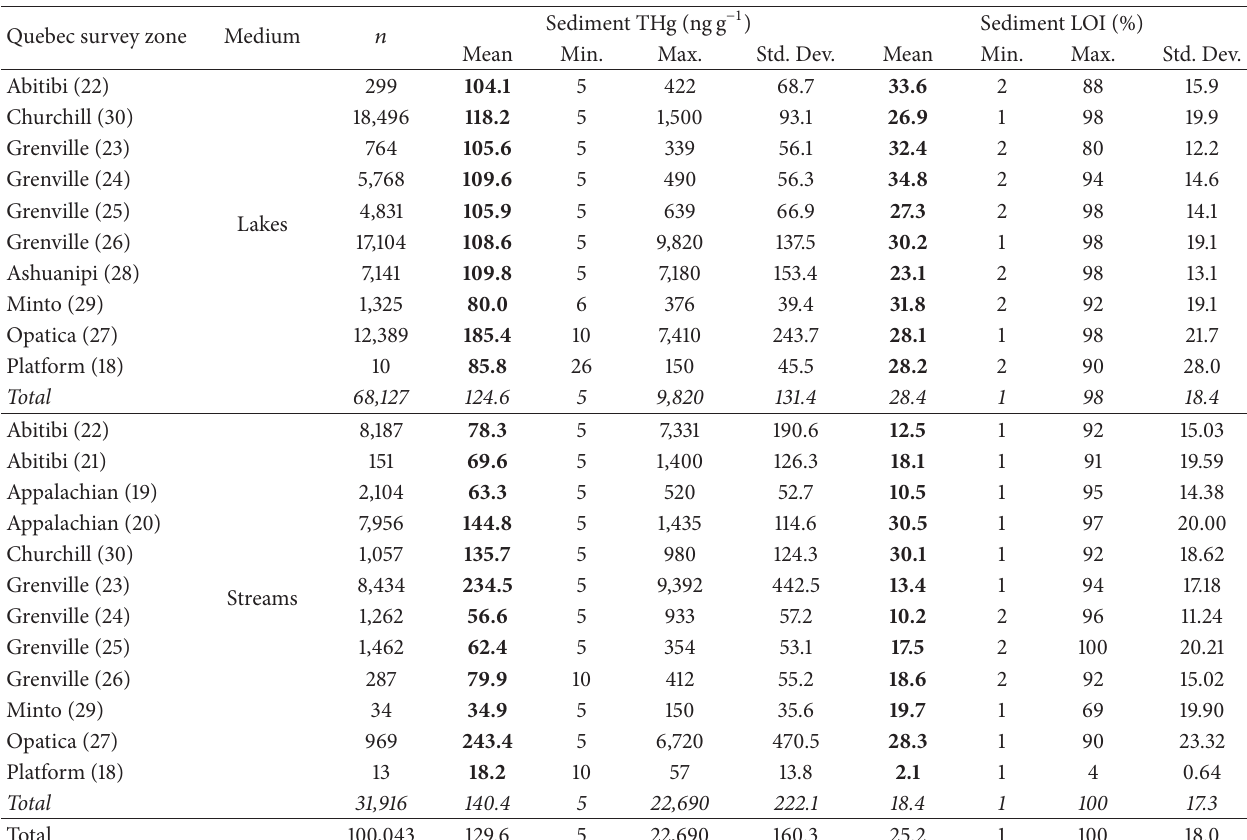
Table 2: Mean sediment THg and LOI for streams and lakes, by Quebec survey zones (Figure 12). Quebec survey